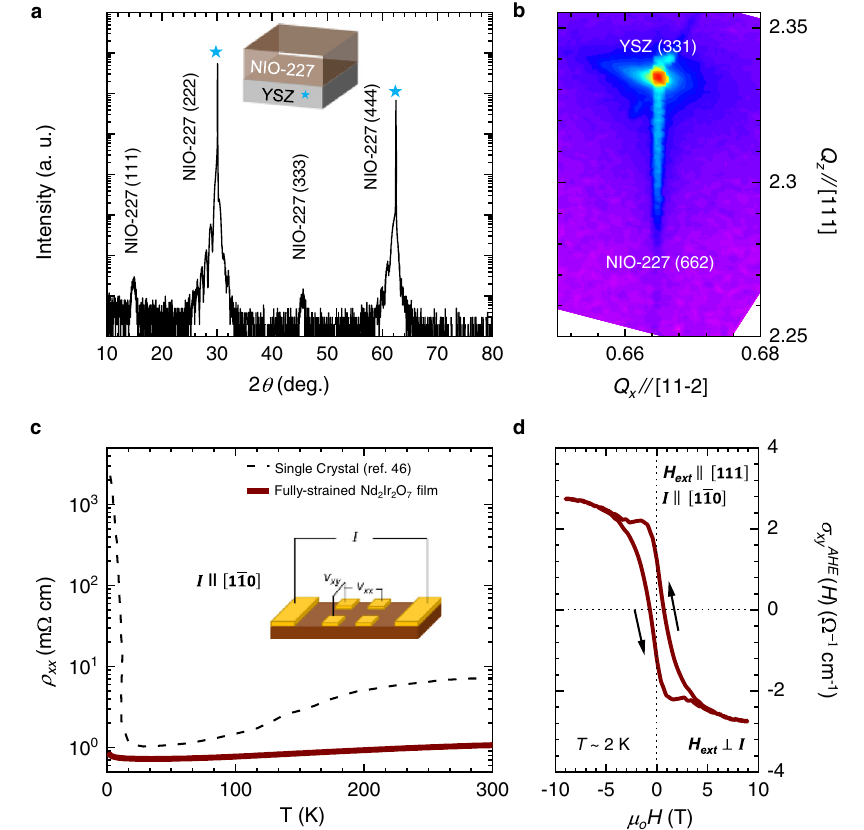
Fig.2|CharacterizationofaNd 2 Ir 2 O 7 thin fi lm.a High-resolutionXRDpatternof a 15 nm thick Nd2Ir2O7 (NIO-227) thin fi lm. The NIO-227 thin fi lm was grown on a YSZsubstrate. b ReciprocalspacemapoftheNIO-227 fi lminthevicinityoftheYSZ (331) re fl ection, indicating that the NIO-227 fi lm is fully strained. c The plot of the longitudinal resistivity, ρ xx , vs. temperature, T , of NIO-227 thin fi lm and single